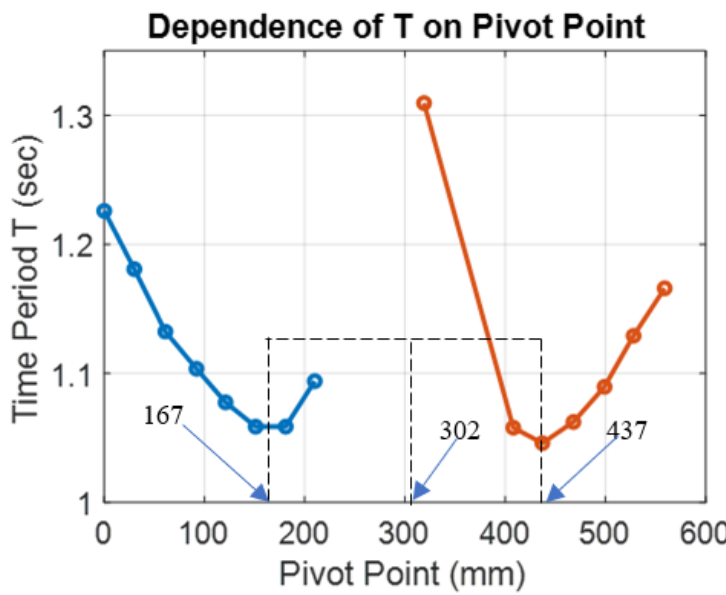
Figure 9. Axes about which the moments of inertia were to be determined.